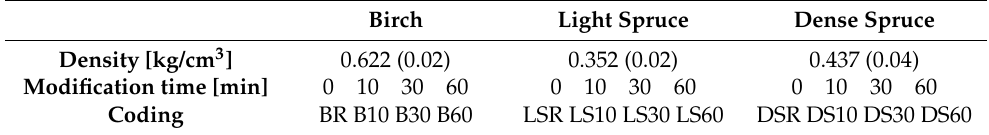
Table 1. Time–temperature regimes and sample groups, standard deviation in parenthesis. Birch Light Spruce Dense Spruce